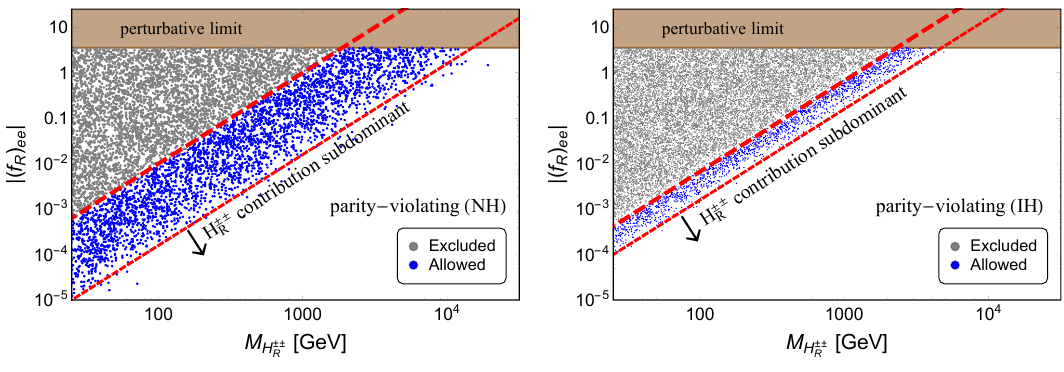
in the parity-violating R